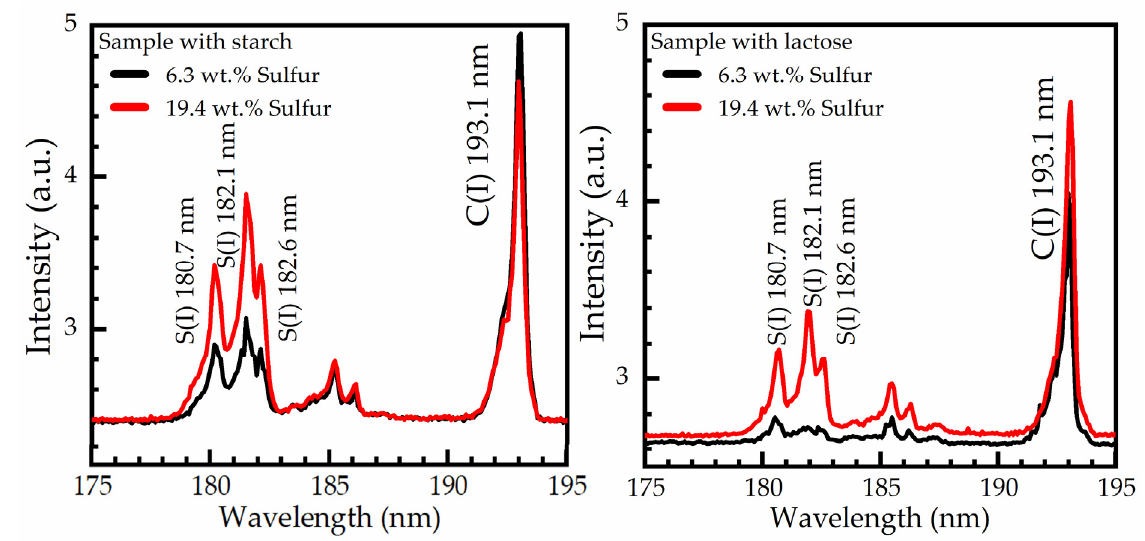
Figure 7. VUV emissions of LIBS spectra of soil-sulfur samples containing starch or lactose as binding material. Table 2. Characteristics (i.e., wavelength, transition probability (A ki ) and lower and upper energy levels (E i , E k )) of the S(I) and C(I) spectral lines observed in the spectral window 180–200 nm.